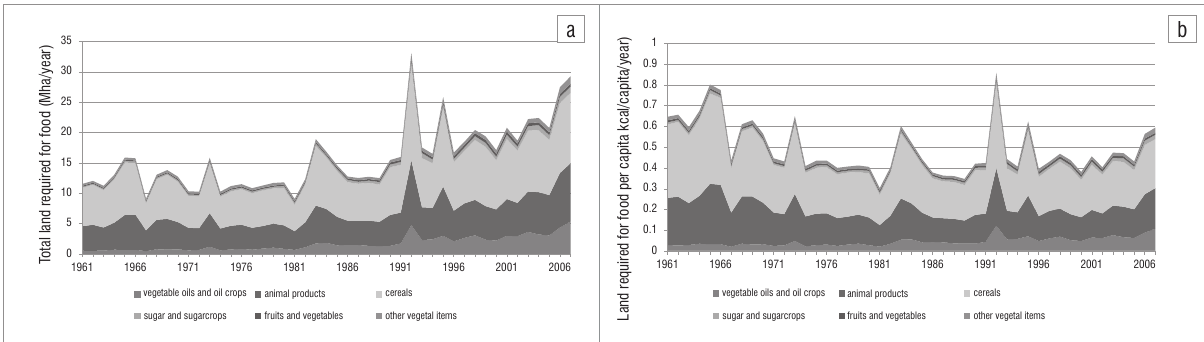
Figure 4: Effect of changes in yield, cropping intensity, population and diet on the land requirements for food (LRF) in South Africa, 1961–2007.